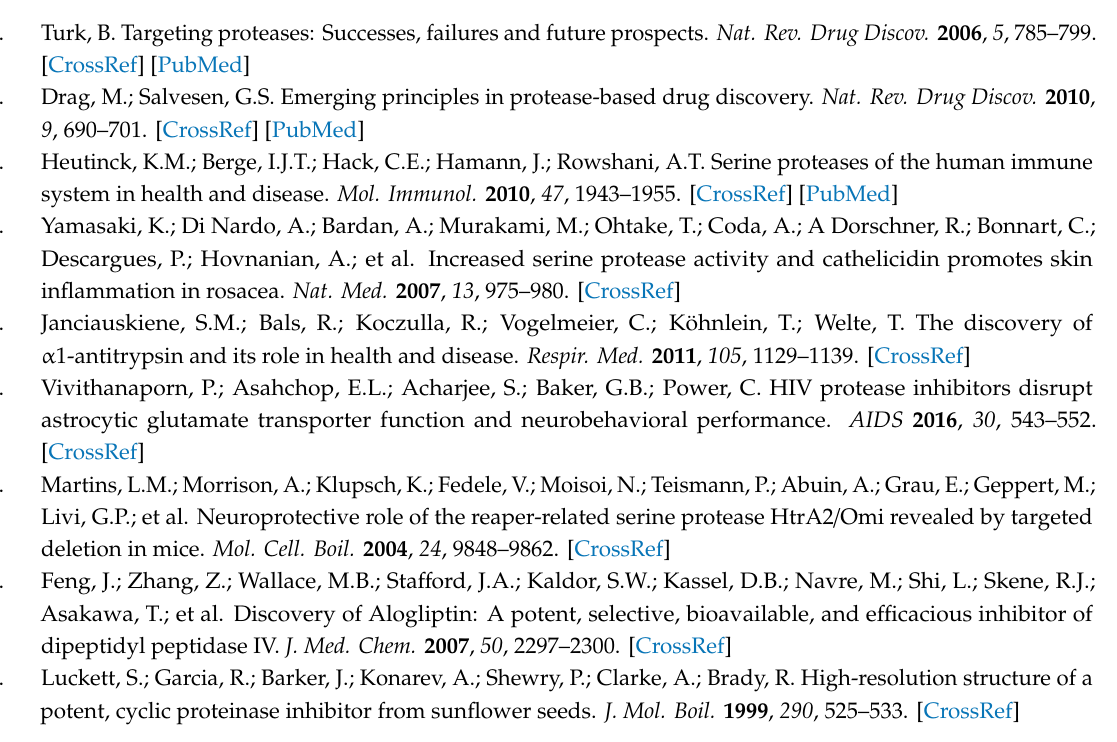
Supplementary Materials: The following are available online. Figure S1: The dose-response curve of oxytocin inhibiting DPP4 at di ff erent concentrations. Table S1: Peptides as DPP4